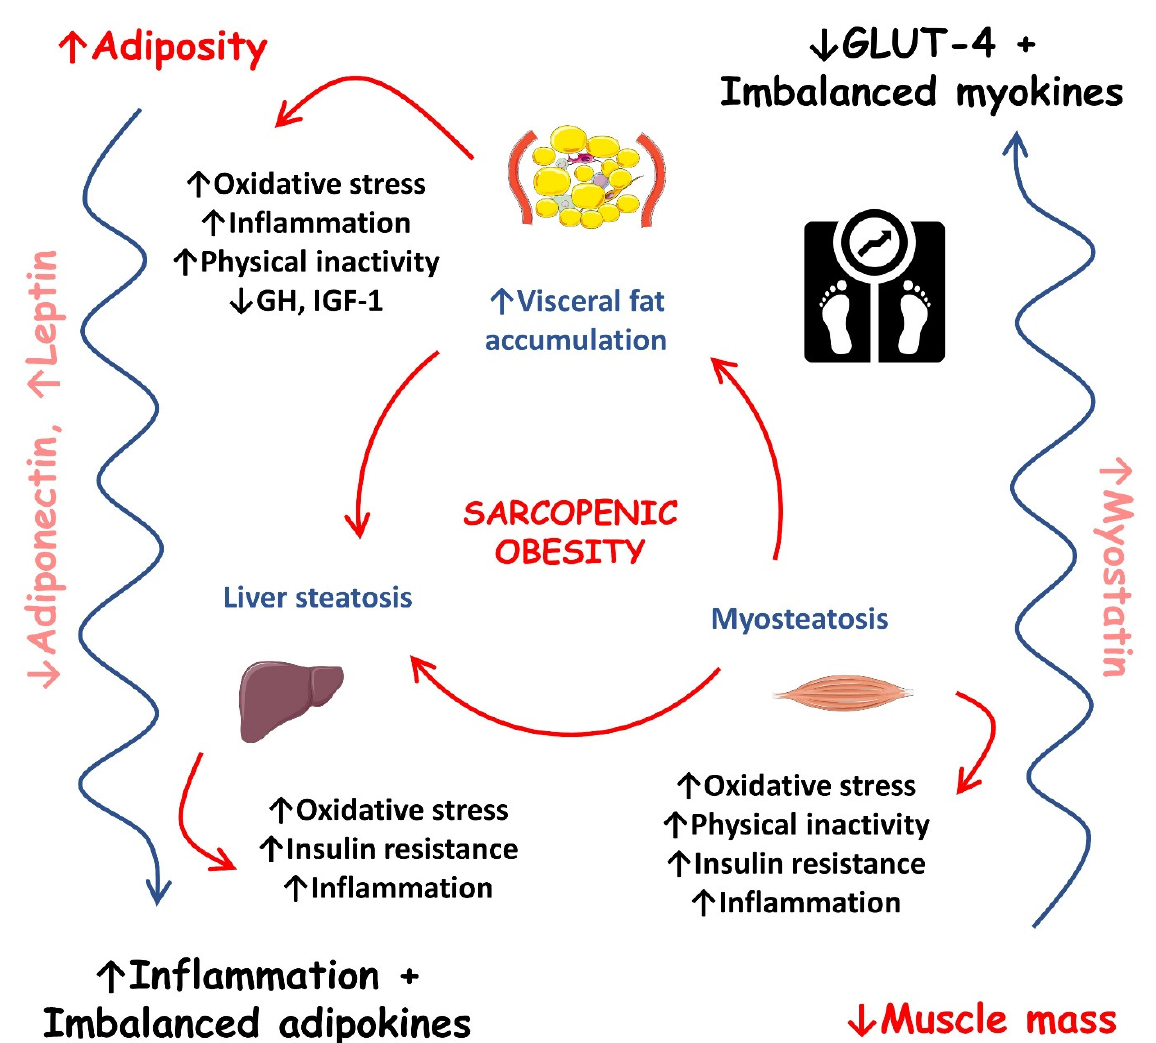
Figure 2. Most important events during sarcopenic obesity development. ↑ , increase; ↓ , decrease; GH, growth hormone; GLUT-4, solute carrier family 2/facilitated glucose transporter member 4; IGF-1, insulin-like growth factor